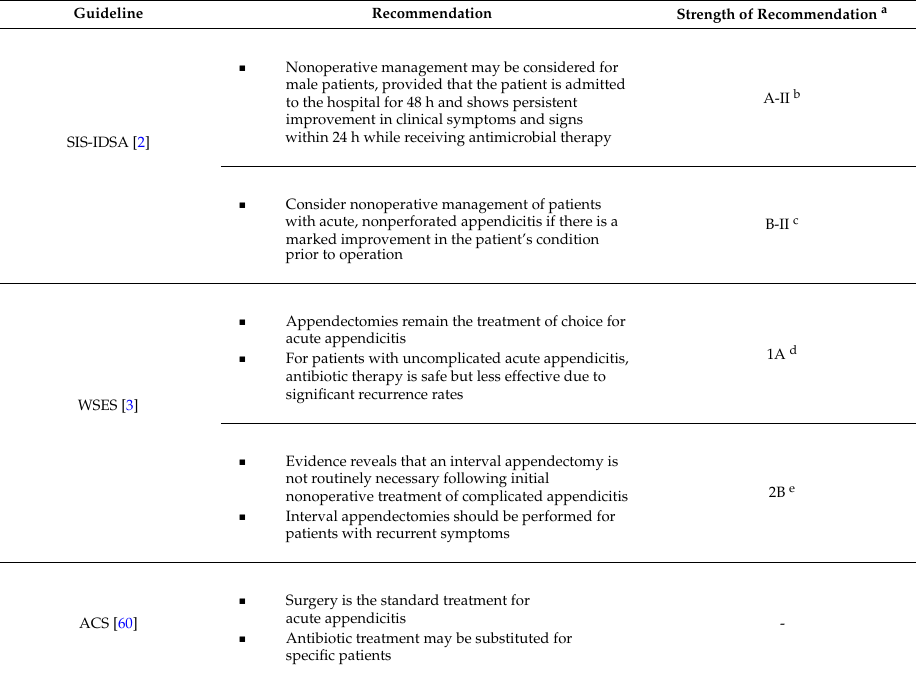
Table 3. Recommendations regarding the use of a nonoperative strategy in the management of appendicitis